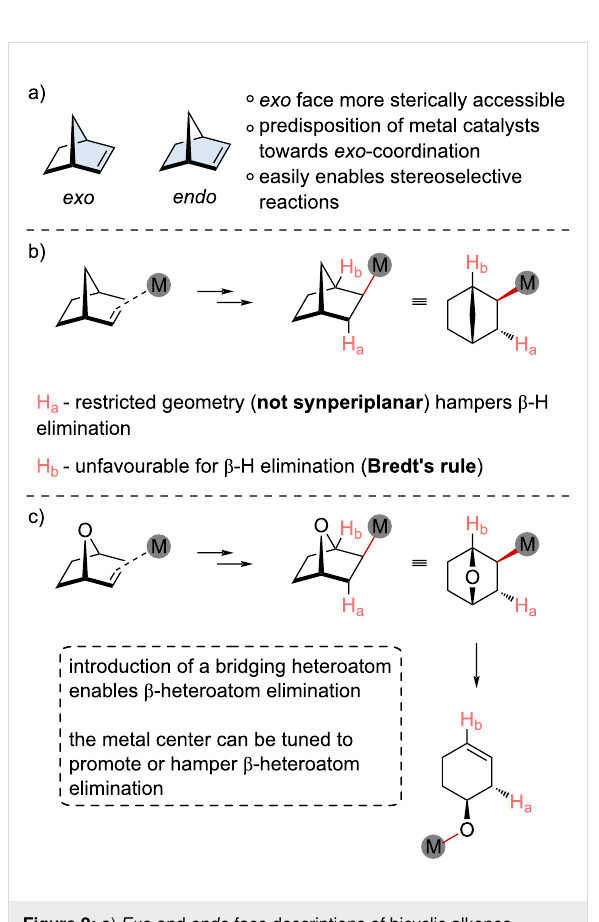
Figure 1: Ring-strain energies of homobicyclic and heterobicyclic alkenes in kcal mol − 1 . a) [2.2.1]-Bicyclic systems. b) [2.3.1]-Bicyclic systems. c) Benzo-fused [2.2.1]-bicyclic systems; ring-strain energy relative to benzonorbornadiene.